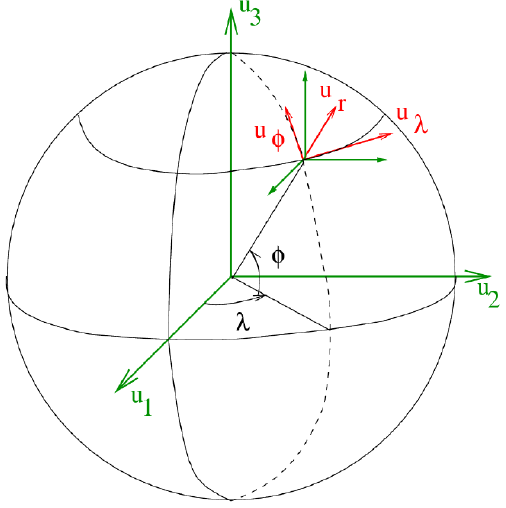
Figure 2. Cartesian and spherical frames for the representation of point coordinates and speed vectors